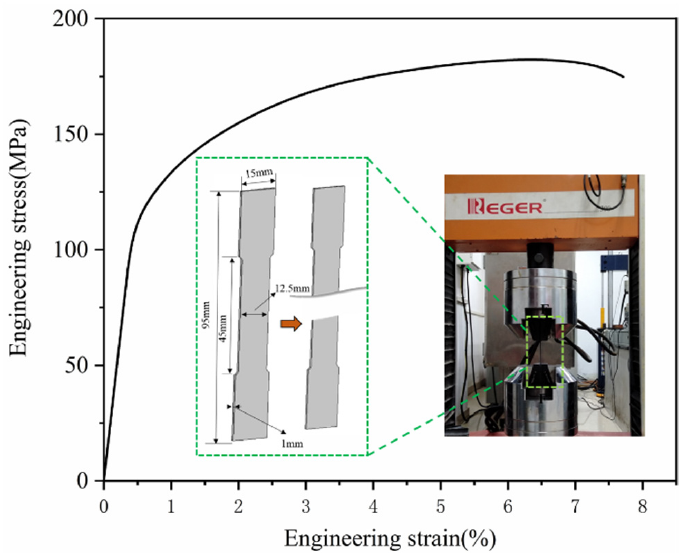
Figure 4. Plastic stress–strain behavior of the aluminum alloy 6082-T6.